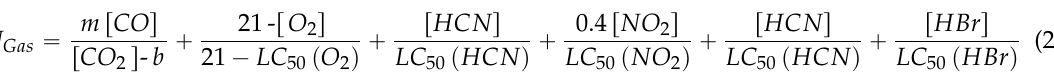
Figure 11. Generation rate of CO 2 for material B with HRR in the heat flux of 30kW/m 2 ( a ); and 50kW/m 2 ( b ).